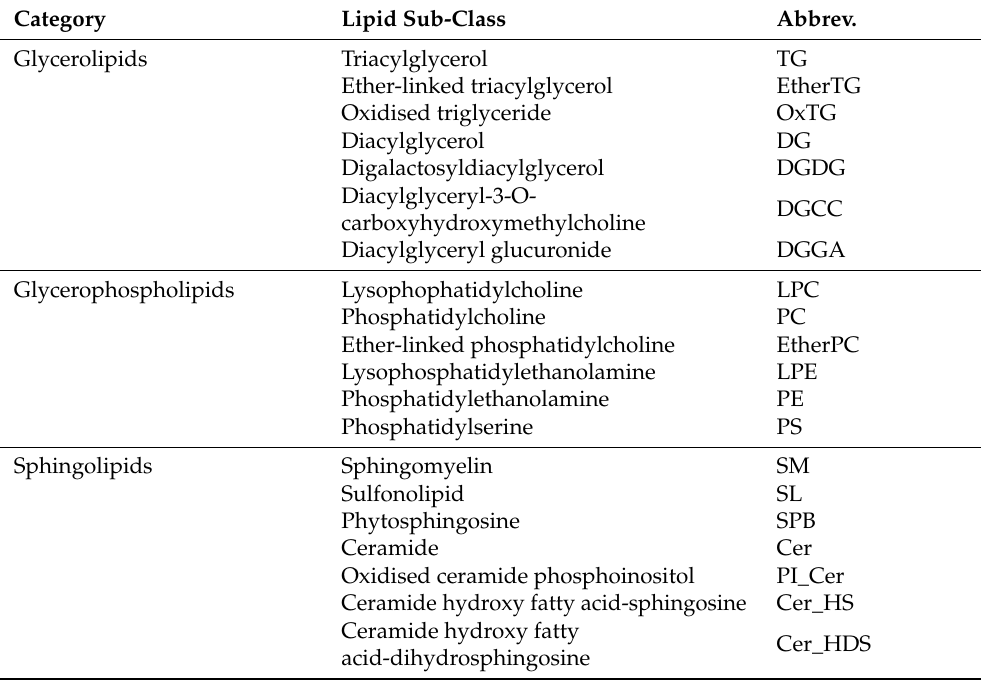
Figure 1. OPLS-DA score plot of ( a ) 20 different lipids ( p -value < 0.05), between brown adipose tissue (BAT) samples from Group 2 (20–22 ◦ C, AT in red) vs. Group 3 (4 ◦ C, cold in blue), after 2 days of exposure; ( b ) 20 different lipids ( p -value < 0.05), between plasma samples from Group 2 (20–22 ◦ C, AT in red) vs. Group 3 (4 ◦ C, cold in blue), after 1 day of exposure; ( c ) 74 different lipids ( p -value < 0.05), between plasma samples from Group 2 (20–22 ◦ C, AT in red) vs. Group 3 (4 ◦ C, cold in blue), after 2 days of exposure. Table 1. Abbreviations of lipid sub-classes used throughout this paper.